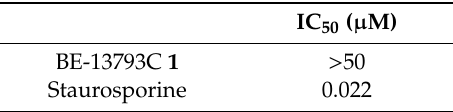
Table 5. Antitrypanosomal activity of 1